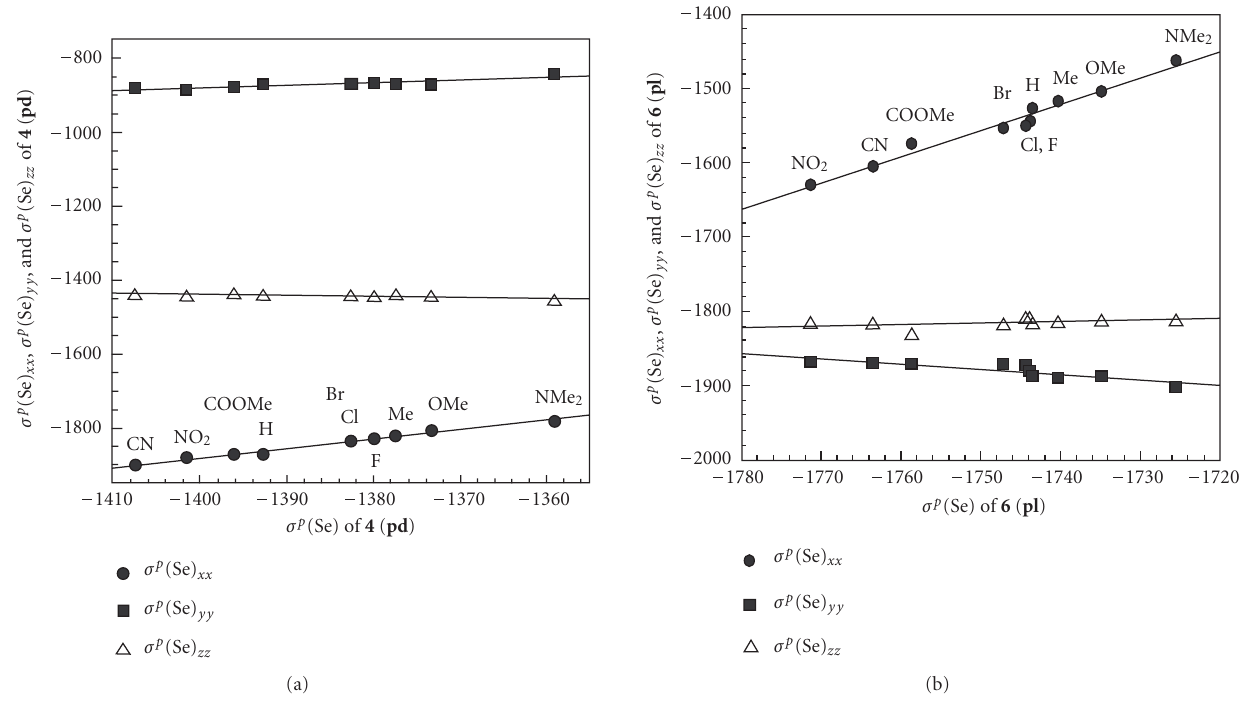
• Figure 3: Plots of σ p (Se) xx ( ), σ p (Se) yy ( (cid:4) ), and σ p (Se) zz ( (cid:5) ) versus σ p (Se): (a) for 4 ( pd ) and (b) for 6 ( pl ).